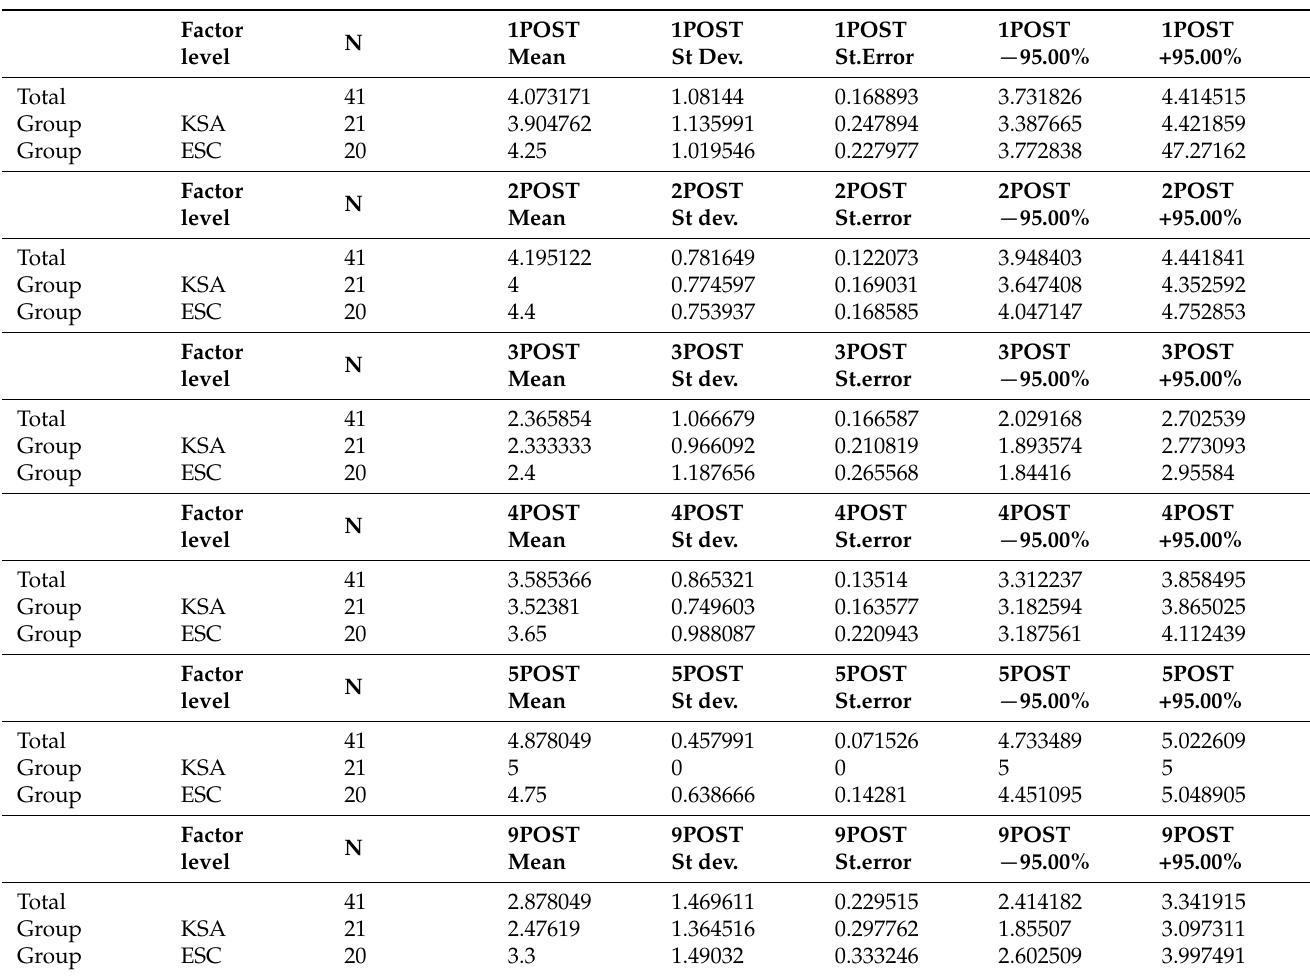
Table 4. The descriptive characteristics and confidence intervals of the